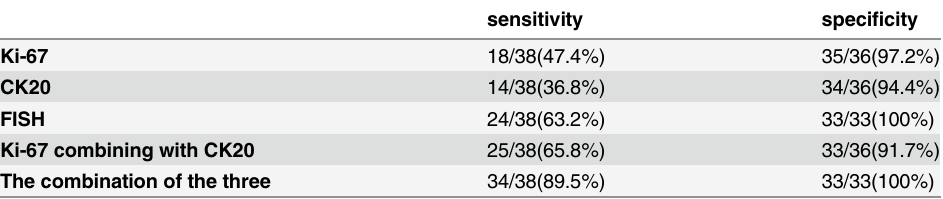
Table 5. Comparison of the sensitivity and specificity of Ki-67, CK20, FISH in IUP and LGNUC with an inverted growth